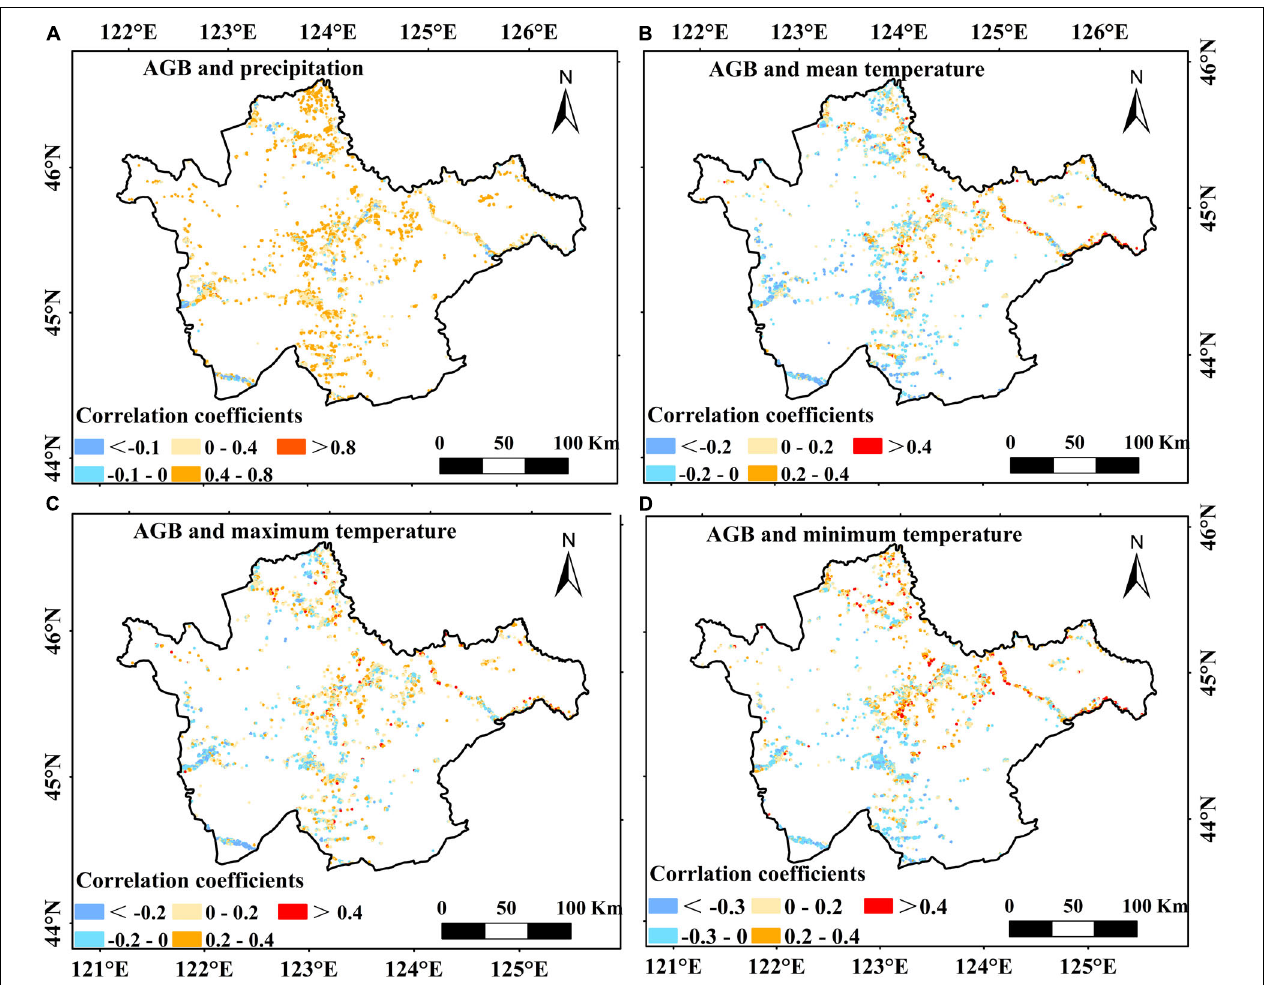
FIGURE 5 | Spatial distributions of correlation coefficients between the annual AGB and annual precipitation (A) , annual mean temperature (B) , annual maximum temperature (C) , and annual minimum temperature (D) in the western Songnen Plain marshes.